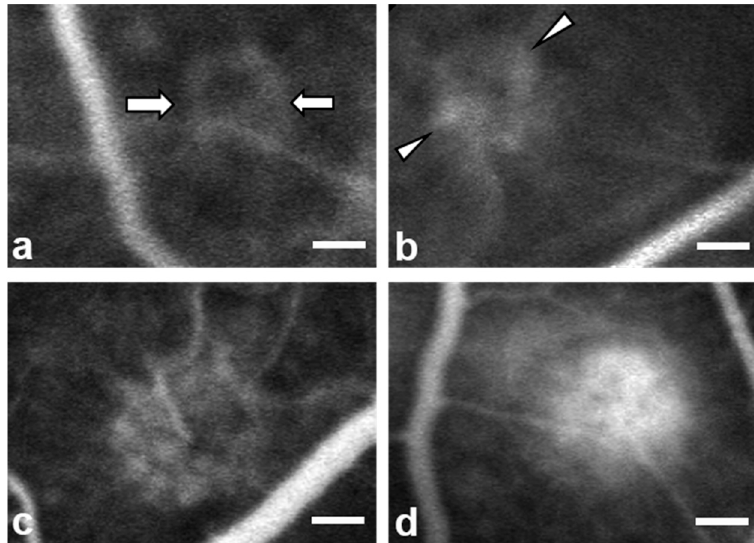
Figure 5. Fluorescein angiography images showing standard examples of each choroidal neovascularization grade after laser treatment in the rat retina. Each photocoagulated lesion was graded (1–4) according to the size and intensity of fluorescein dye leakage. (a) Grade 1, minimum leakage or staining of tissue with no leakage (arrows). (b) Grade 2, small but evident leakage (arrowheads). (c) Grade 3, moderate intensity and medium-sized (diameter < 1/2 disc) leakage. (d) Grade 4, large and evident leakage. Scale bar = 50 μ